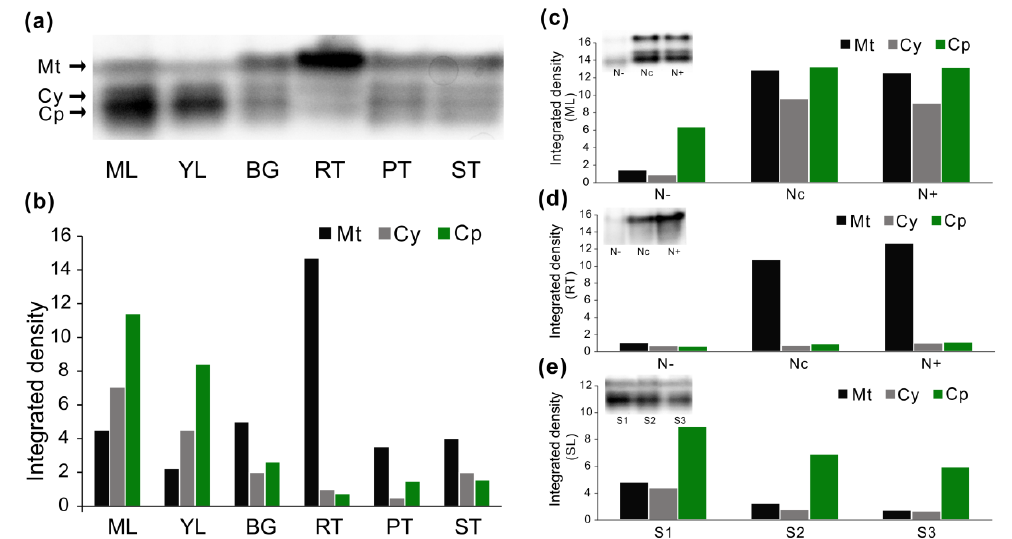
Figure 8. E ff ects of AspAT activities in response to the perturbation of N nutrients and seasonal senescence. ( a , b ) Determination of AspAT activities in various tissues of poplar ‘ Nanlin895 ’ in native gel and signal strength was quantified by ImageJ. ML (mature leaves), YL (young leaves), BG (green barks), RT (roots), PT (petioles), and ST (stems). ( c , d ) E ff ects of enzyme activities upon perturbations of N nutrients in roots and leaves, respectively. ( e ) E ff ects of enzyme activities in leaves upon seasonal senescence. Samples were harvested as described in Figure 6. Each well was loaded with an equal amount (30 µ g) of extracted protein and enzyme activities were assayed in native PAGE gels. The enzyme activity data represent one of three independent biological replicate s and every replicate showed similar patterns.